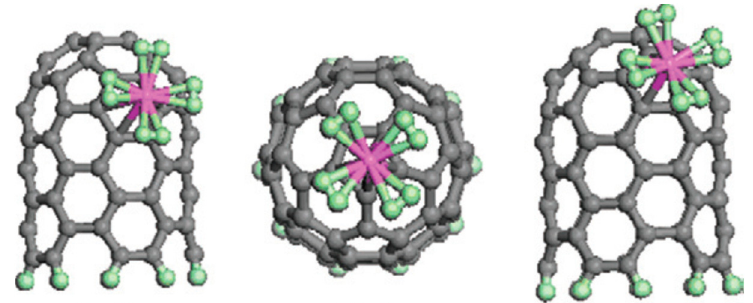
Figure 6. Schematic representation of hydrogen spillover mechanism on Pd dispersed carbon nanotube [130] .